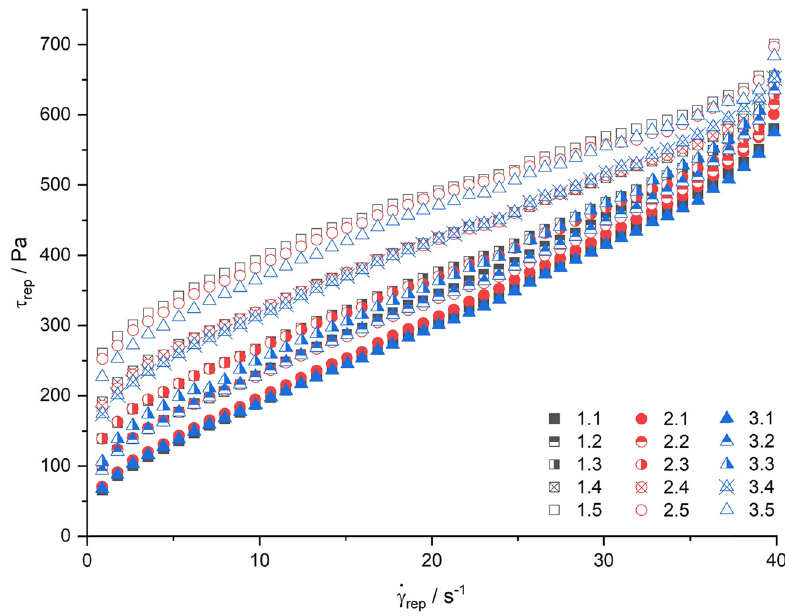
Figure 6: Representative values of SCC, measured in the standard process with modi fi ed aluminium pro fi